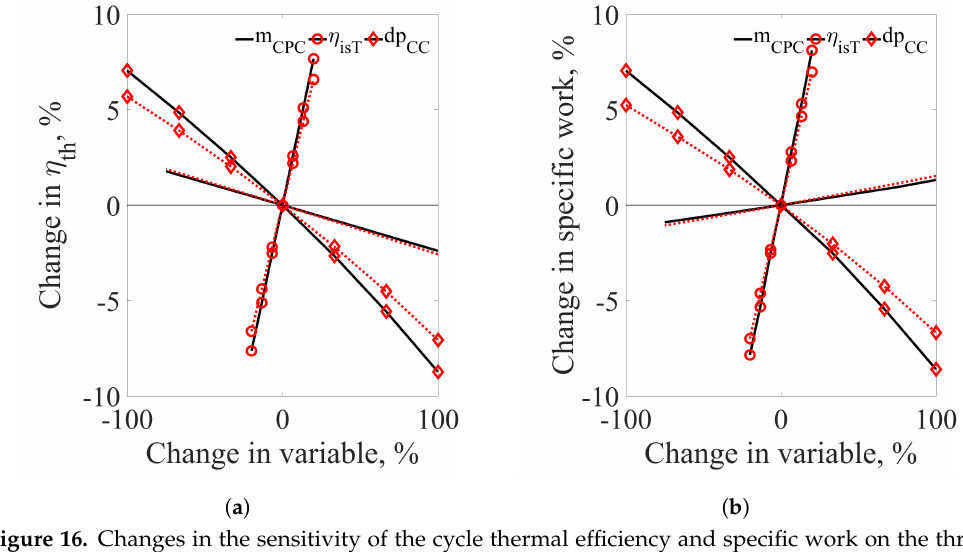
Figure 16. Changes in the sensitivity of the cycle thermal efficiency and specific work on the three cycle parameters presented in Table 4, due to a different TIT value. Pressure ratio: 10. The continuous lines refer to a TIT = 1300 ◦ C and the dotted lines to TIT = 1700 ◦ C. ( a ) Sensitivity of the cycle thermal efficiency; ( b ) Sensitivity of the cycle specific